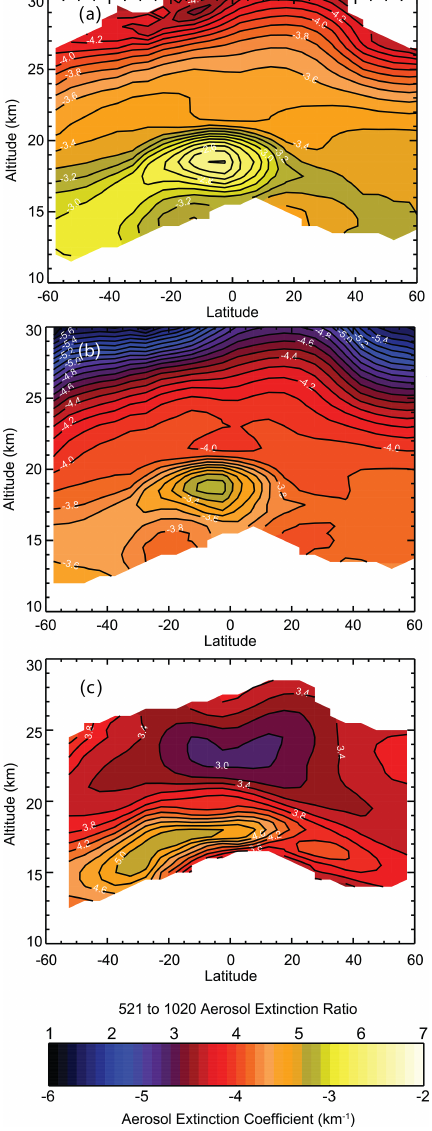
Figure 9. The mean SAGE III/ISS 525 (a) and 1020nm (b) aerosol extinction coefficient and the 525 to 1020nm aerosol extinction coefficient ratio (c) as a function of latitude and altitude from September 2019, shortly after the second 2019 eruption of Ambae (July 2019; 15 ◦ S).